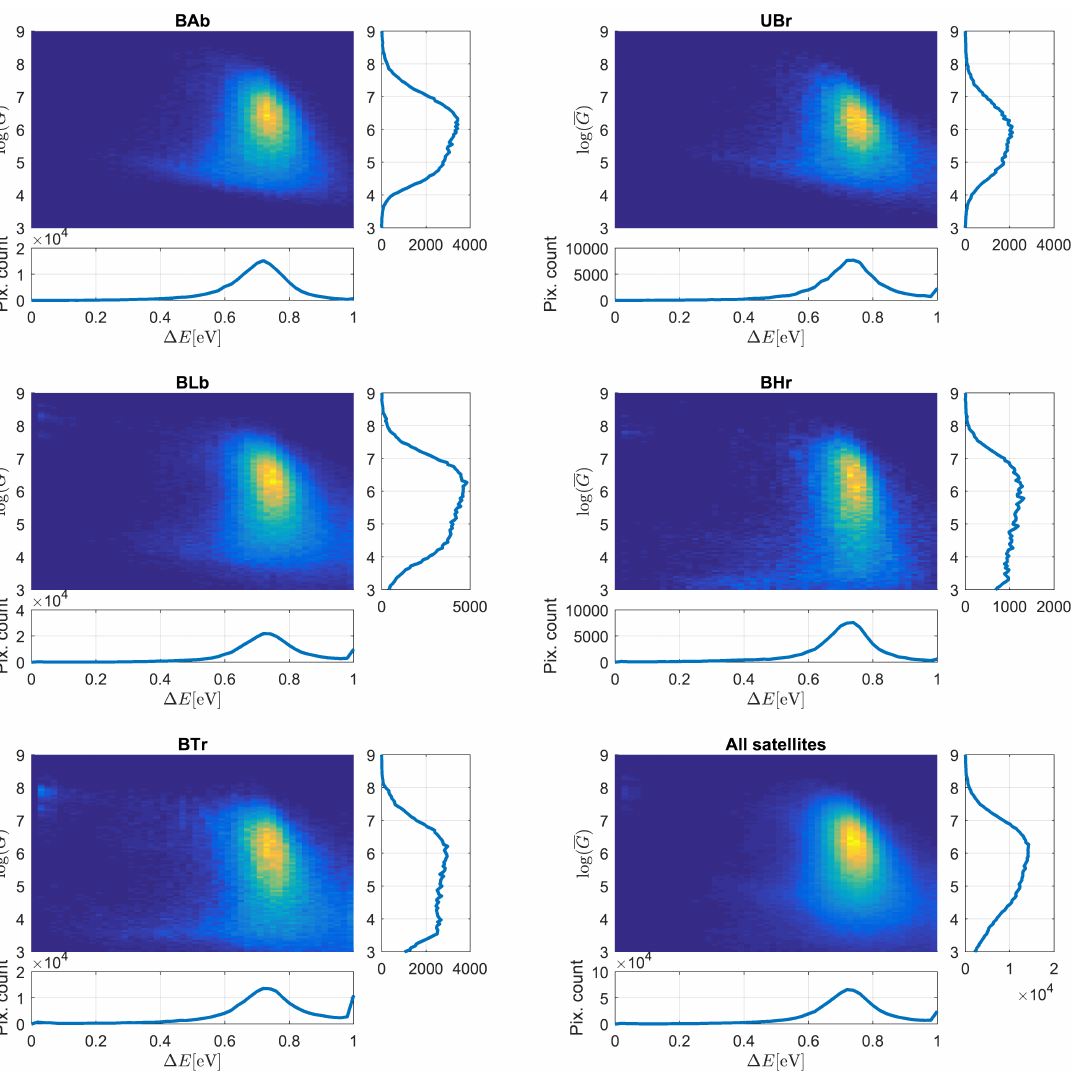
Figure 10. Dependencies between the two constants, ∆ E energy and log G prefactor, characterizing a detected metastable state in a blinking